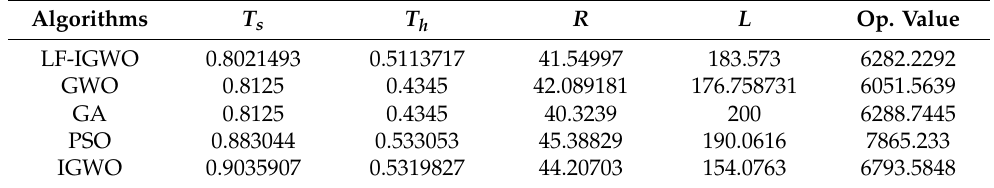
Table 12. Comparison of cost values obtained from LF-IGWO with other techniques. Algorithms T s T h R L Op. Value LF-IGWO